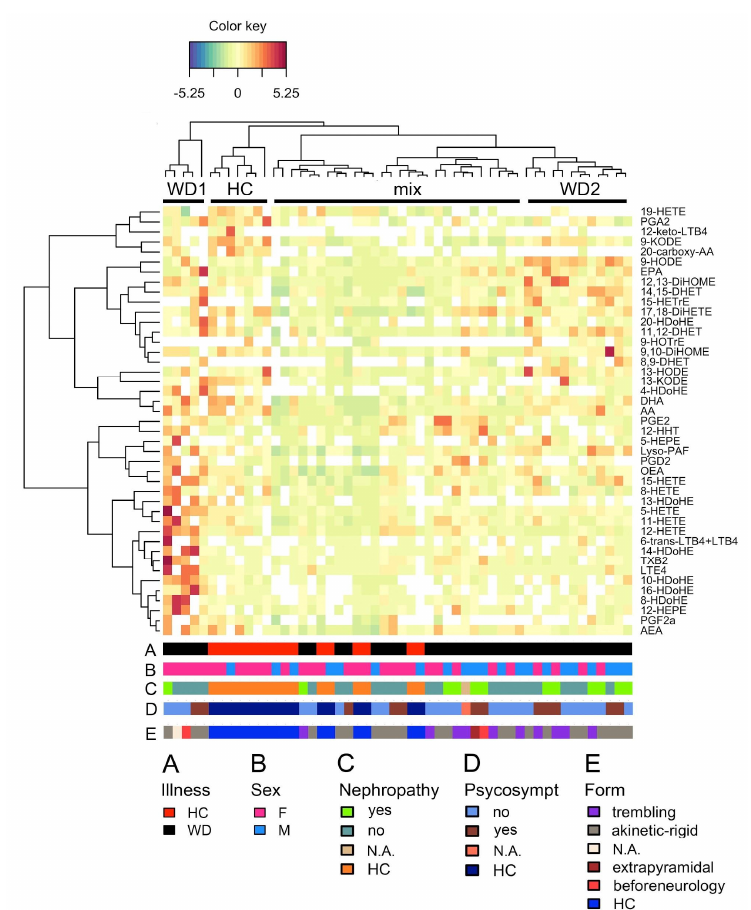
Figure 3. A clustered image map was generated using the Euclidean distance and the complete linkage clustering algorithm. On the figure, each entry of the matrix is colored according to its value; rows represent metabolites, columns represent subjects. Dendrograms are shown on the left side (for patients) and on top (for metabolites). Color bars on the bottom of the picture indicate: ( A ) whether the subjects belongs to the Wilson disease (WD) group or healthy control (HC) group; ( B ) sex distribution: male (M) or female (F); ( C ) nephropathy status: no, yes, HC or data not available (N.A.); ( D ) psychosomatic status: no, yes, HC or N.A.; ( E ) form of the disease: trembling, akinetic-rigid, extrapyramidal, beforeneurology, or HC.